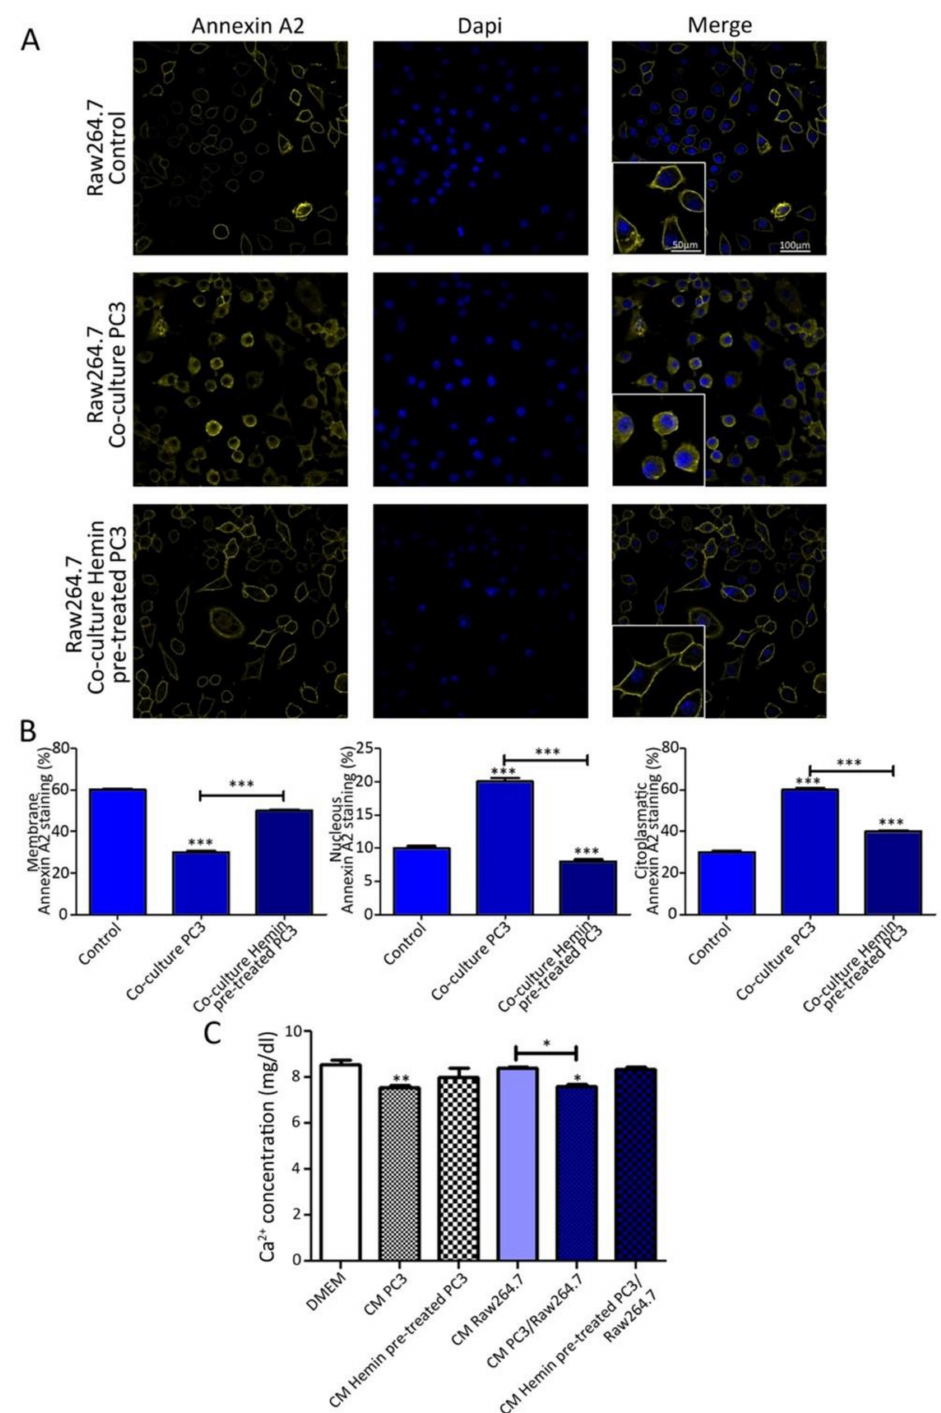
Figure 2. ANXA2 subcellular localization in osteoclasts progenitors when co-cultured with tumor cells and under HO-1 induction. ( A ) Immunofluorescence (IF) staining and confocal microscopy analysis for ANXA2 on Raw264.7 grown alone or in co-culture with PC3 cells pre-treated or not with hemin (50 µ M; 24 h). ( B ) Semi-quantitative analyses of the IF by segmentation of the whole cell, intracellular, and nucleus (DAPI). The florescence intensity for ANXA2 was calculated using ImageJ and normalized to cell size ( n ≥ 180 cells for each condition). Percentage of staining in each compartment by cell-by-cell analysis is depicted. ( C ) Ca 2 + concentration levels of conditioned media from PC3 and Raw264.7 cells growing in co-culture conditions. Statistical significance is shown with respect to the unconditioned DMEM medium. Bars depict comparisons among the other conditions. Significant di ff erences: * p < 0.05, ** p < 0.01; *** p <